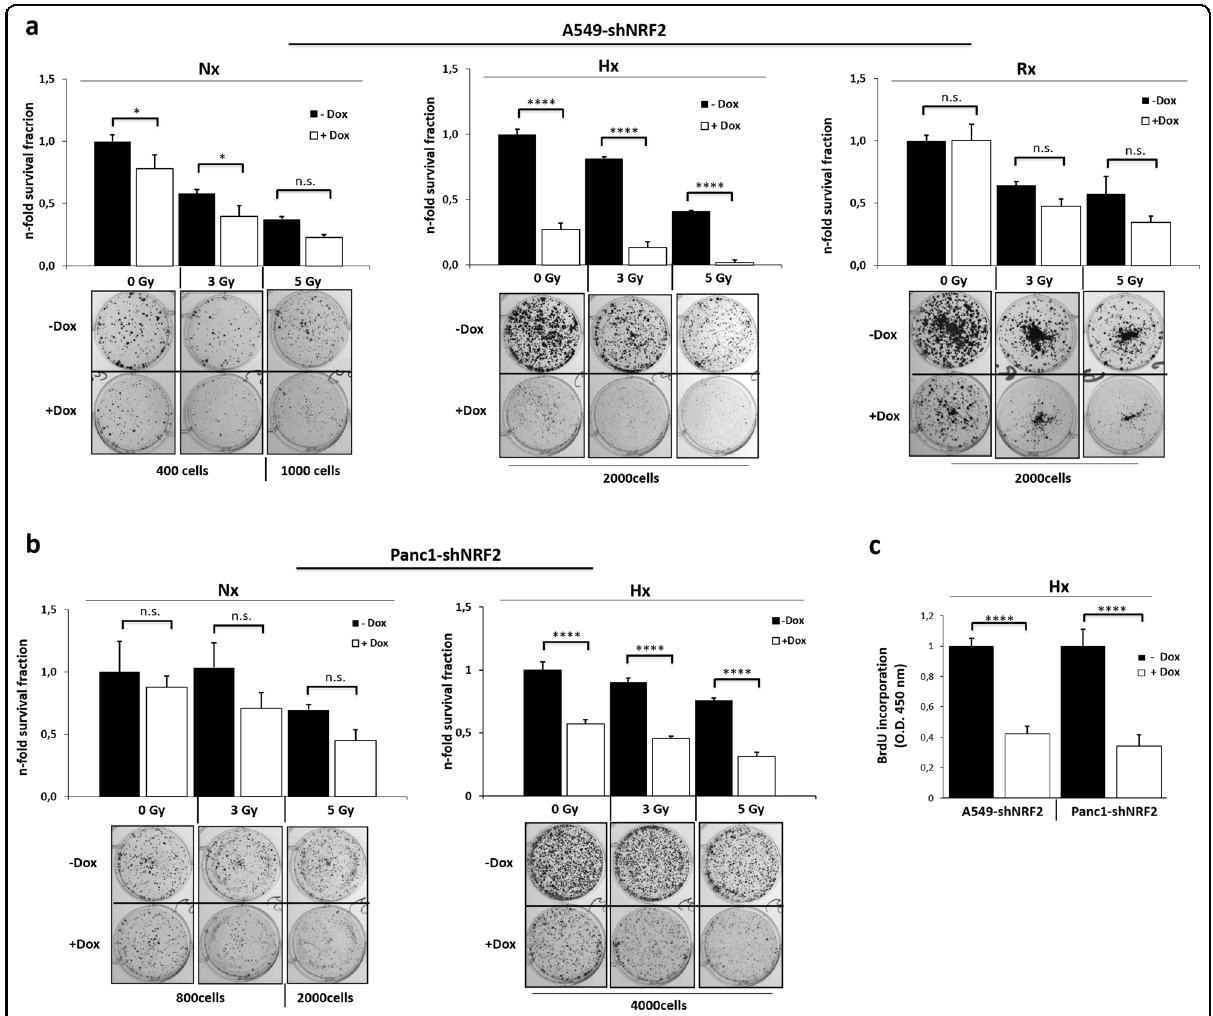
Fig. 2 Survival of irradiated A549 and PANC1 cells after NRF2 KD depends on the oxygen level. Clonogenic survival assay of A549-shNRF2 cells ( a ) and PANC1-shNRF2 cells ( b ) after irradiation combined with NRF2 KD. Hypoxic A549-shNRF2 cells were reoxygenated (RX) right after radiation treatment and kept in normoxia until the end of the experiment. c BrdU proliferation assay in hypoxia was performed 72 h after NRF2